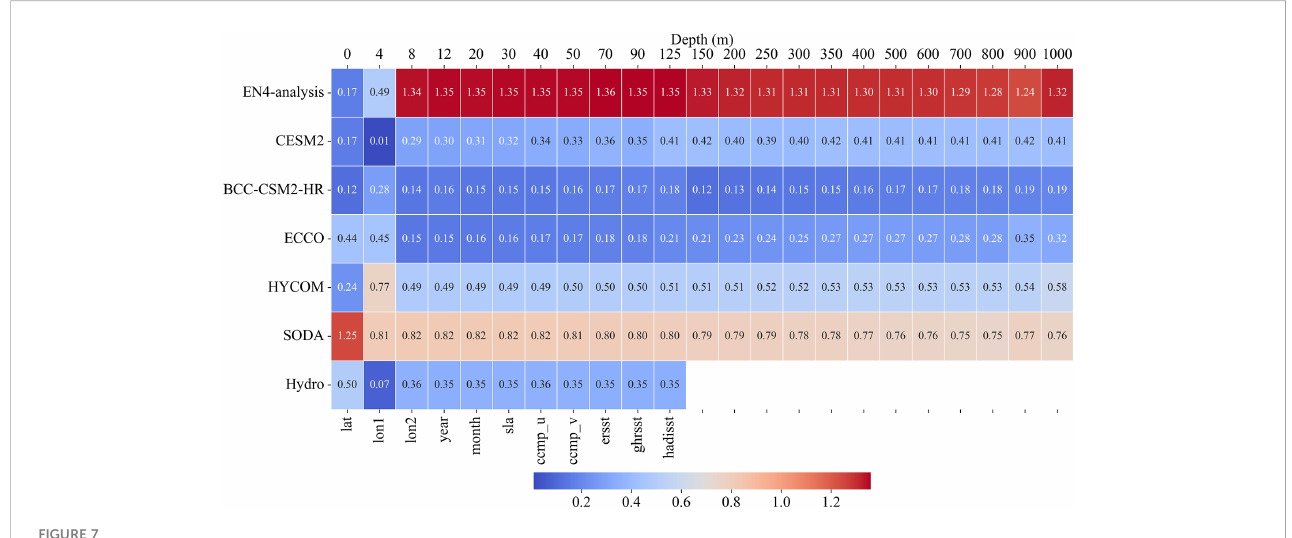
FIGURE 7 Heat map of GAM attention